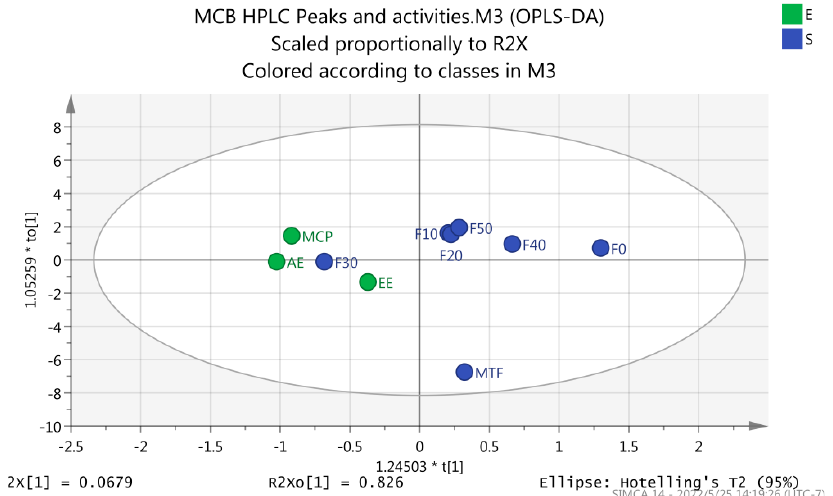
Figure 12. Scores of MCB extracts and fractions (OPLS − DA). EE: ethanol extract, AE: aqueous extract, MTF: total flavonoids, MCP: crude polysaccharides, macroporous resin fractional eluent: F0, F10, F20, F30, F40 and F50.